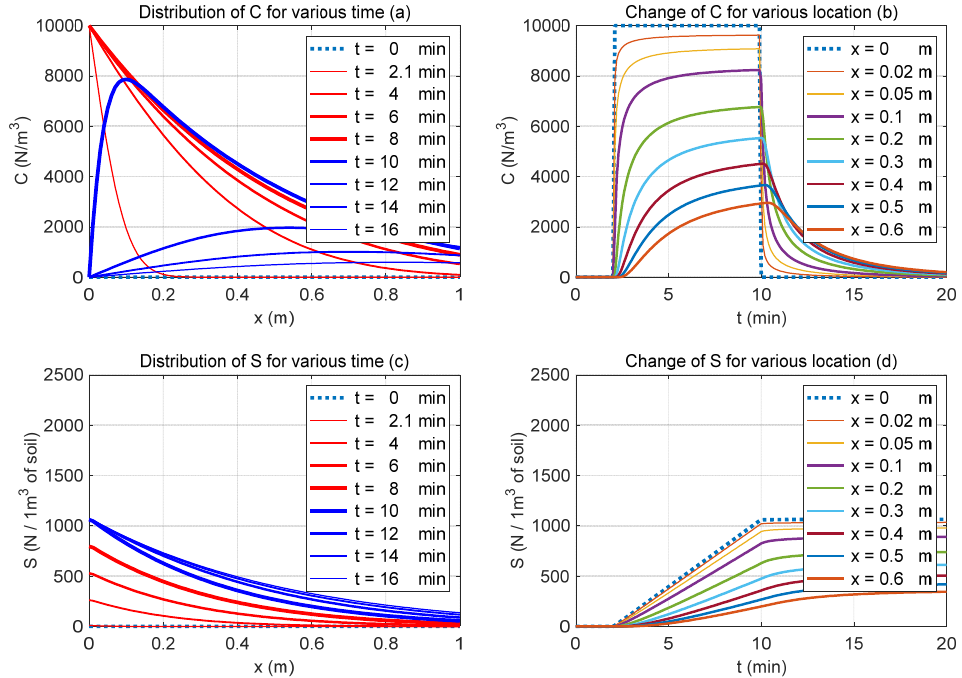
Figure 4. Simulation results for case S1 ( D = 4 D 0 ): ( a ) distribution of C at various times, ( b ) variation in C at various locations, ( c ) distribution of S at various times, and ( d ) variation in S at various locations.